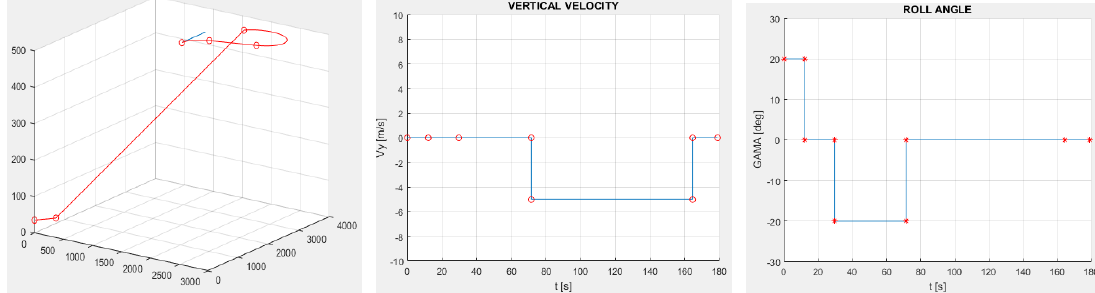
Figure 23. The altitude, vertical velocity, and roll angle when the UAV must land in the given direction.